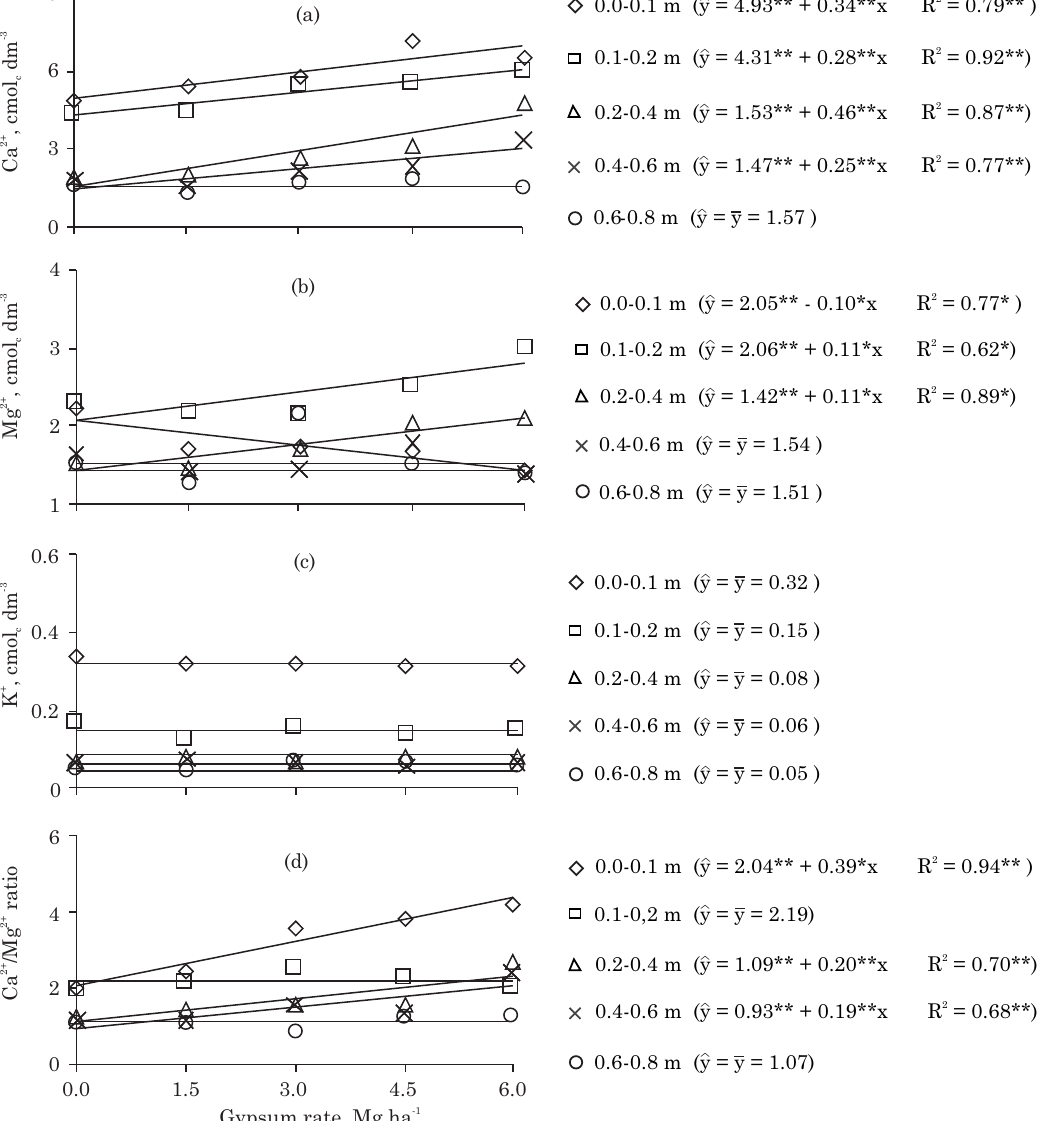
Figure 3. Contents of calcium (Ca 2+ ), magnesium (Mg 2+ ), potassium (K + ), and Ca 2+ /Mg 2+ ratio in soil layers, six months after surface application of gypsum under a no-till system. * p<0.05 and **